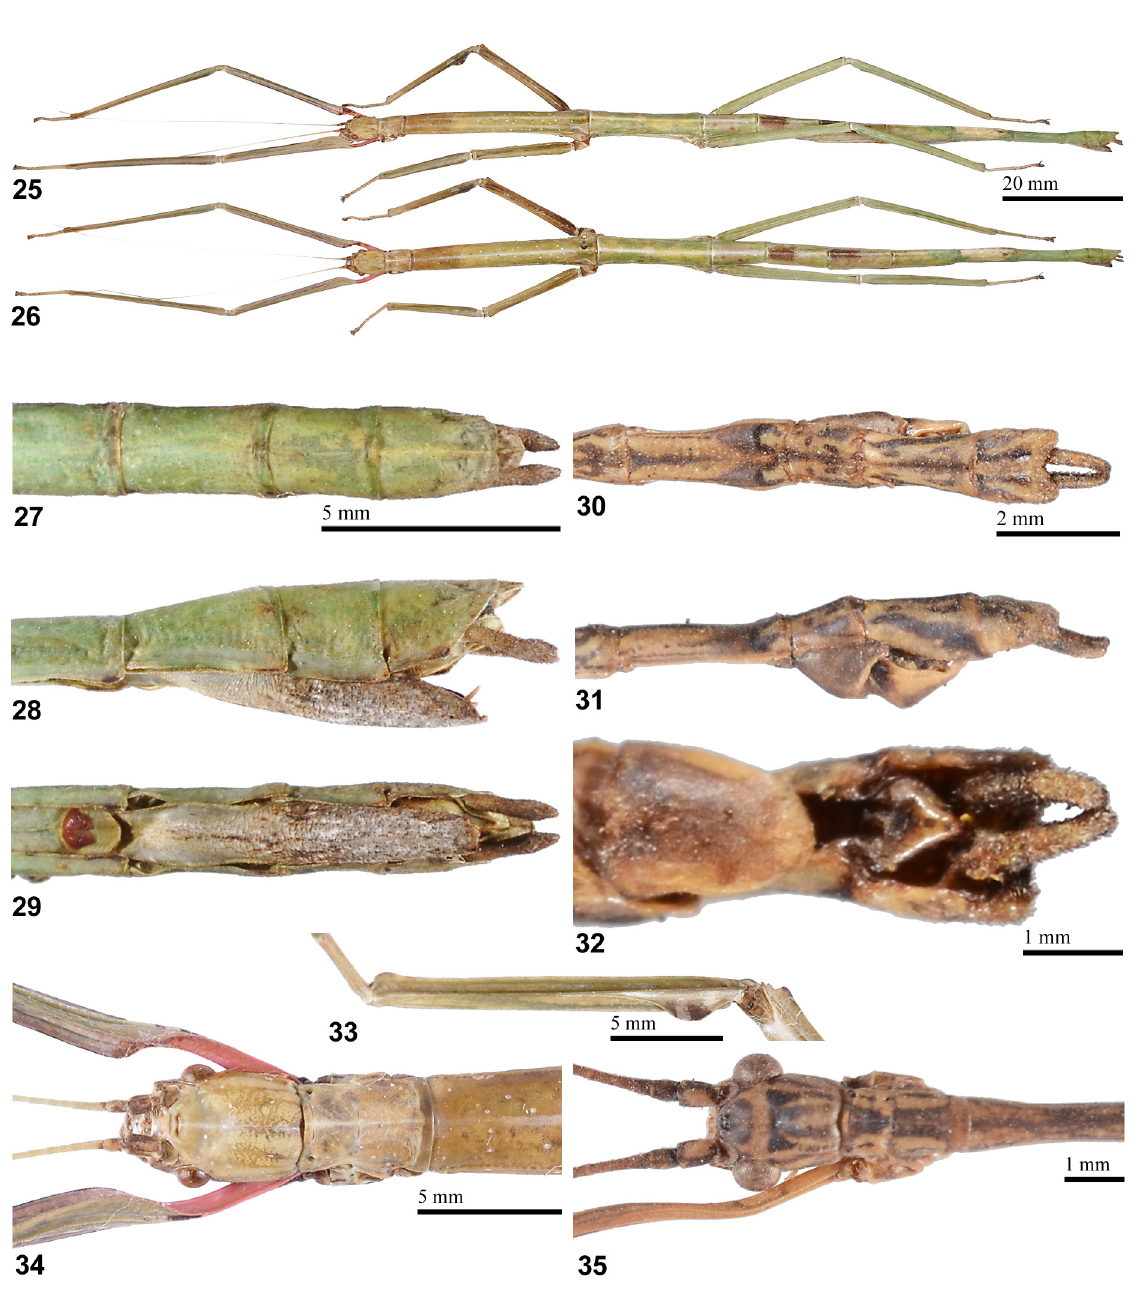
Figs 25–35. Phantasca guianensis sp. nov. 25 . Holotype, ♀ , habitus, dorsolateral view. 26 . Holotype , ♀, habitus, dorsal view. 27 . Holotype, ♀ , apex of abdomen, dorsal view. 28 . Holotype, ♀, apex of abdomen, lateral view. 29 . Holotype, ♀, apex of abdomen, ventral view. 30 . Paratype, ♂, apex of abdomen, dorsal view. 31 . Paratype, ♂, apex of abdomen, lateral view. 32 . Paratype, ♂, apex of abdomen, ventral view. 33 . Holotype, ♀, left mesotibia, ventrolateral view. 34 . Holotype, ♀, head, pro- and mesothorax, dorsal view. 35 . Paratype, ♂ , head, pro- and mesothorax, dorsal